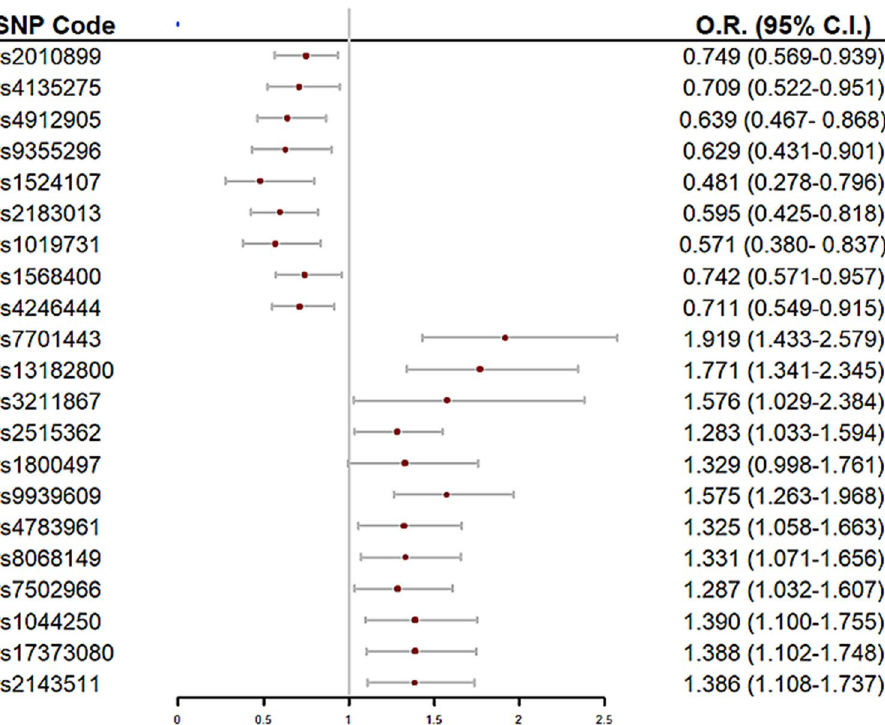
Figure 1. Forest plot of single nucleotide polymorphisms (SNPs) negatively (OR < 1) and positively (OR > 1) associated with risk of OW/OB. Legend: SNPs ordered by chromosome number. Protective SNPs against risk of overweight/obesity are shown in the upper part of the forest plot; SNPs with predisposition risk to overweight/ obesity are shown in the bottom part. Multivariate model Odds Ratio (O.R.) and 95% confidence intervals (C.I.)